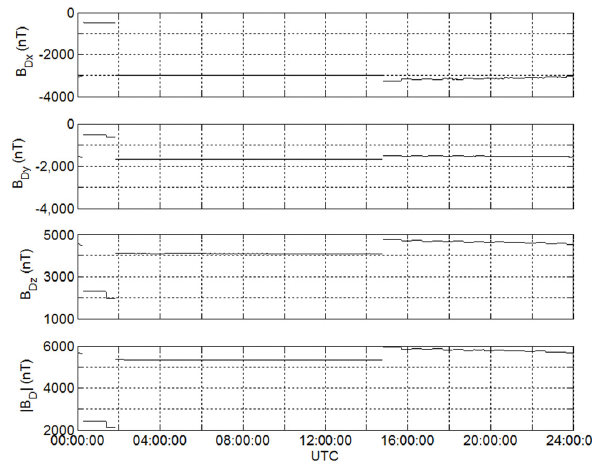
Fig. 1. B Dx (t) (spacecraft coordinate system) for 4h measured on 14 July 2006. The data shows 8 effects (2 of these are illustrated) due to a change in angle of the solar array drive motors. 15 com- plete pairs of periodic spacecraft effects (2 are illustrated) are also present.